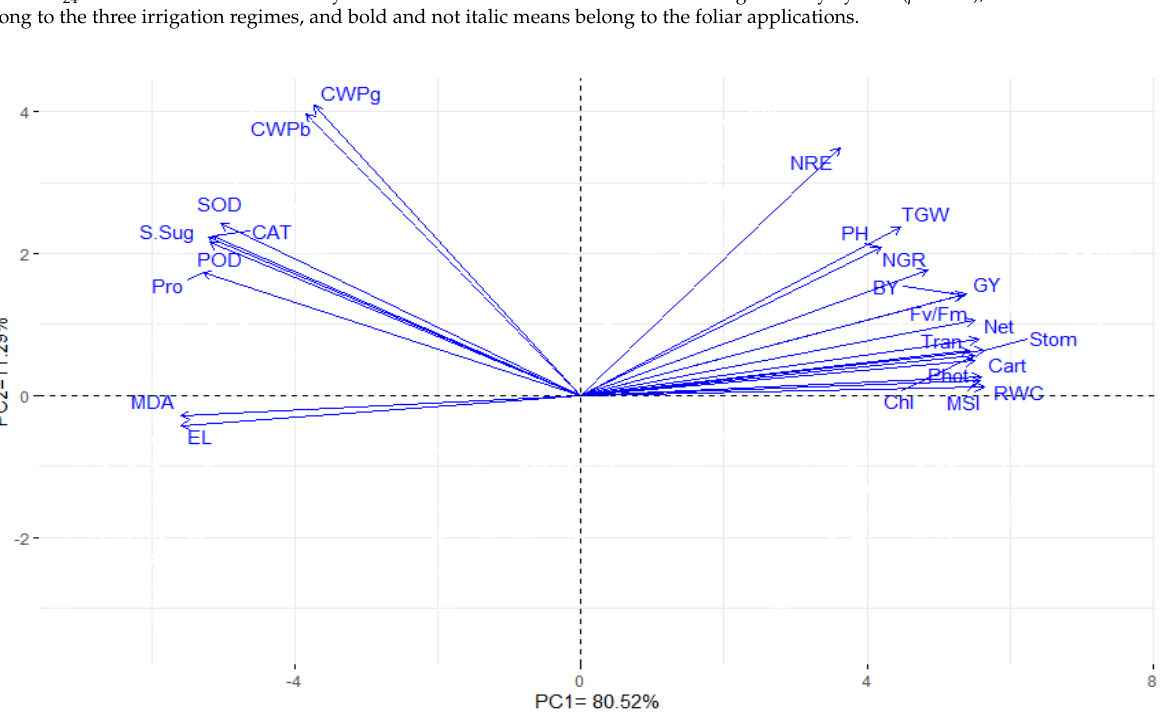
Figure 2. Biplot of the principal components analysis representing the relationship among the evaluated physiological and agronomic traits of six maize hybrids grown under three irrigation regimes over two growing seasons. Chl is total chlorophyll content, Car is the carotenoids content, Phot is the photochemical activity, Fv/Fm is the photosynthetic efficiency, Net is the net photosynthetic rate, Tran is the transpiration rate, Stom is the stomatal conductance, MDA is malondialdehyde, RWC is the relative water content, MSI is the membrane stability index, EL is the electrolyte leakage, S.Sug is soluble sugar, Pro is the proline content, POD is peroxidase, CAT is the catalase activity, SOD is the superoxide dismutase activity, PH is the plant height, NRE is the number of rows per ear, NGR is the number of grains per row, TGW is the 1000-grain weight, GY is the grain yield (kg ha −1 ), BY is the biological yield (kg ha −1 ), CWPg is the crop water productivity of the grain yield (kg m −3 ), and CWPb is the crop water productivity of the biological yield (kg m −3 ).